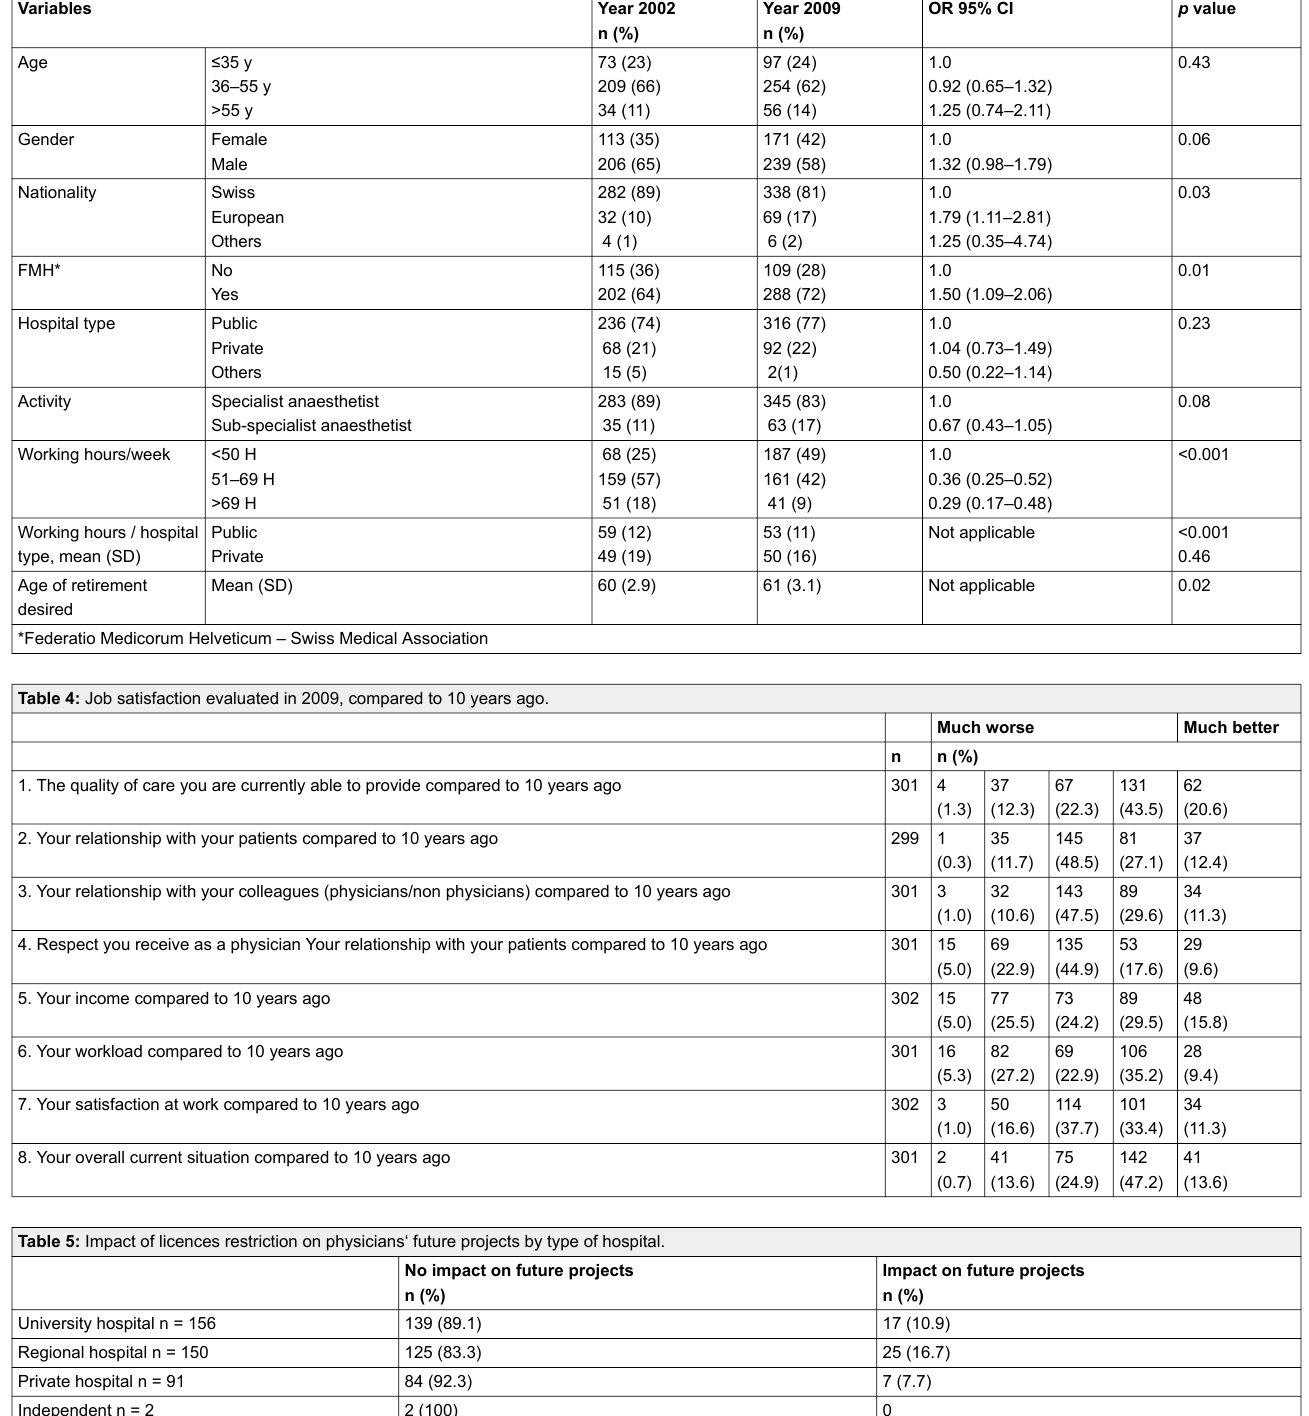
Table 3: Anaesthetists characteristics & working conditions in 2002 and 2009.